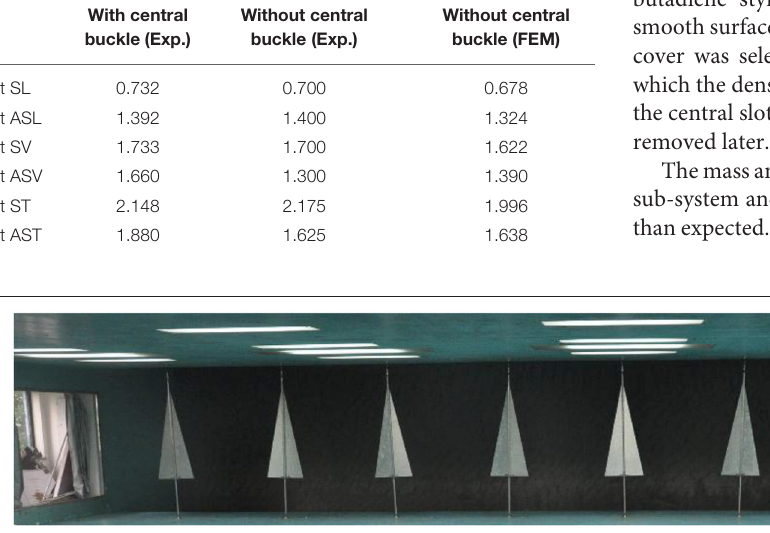
FIGURE 17 | Mobile spires for turbulence